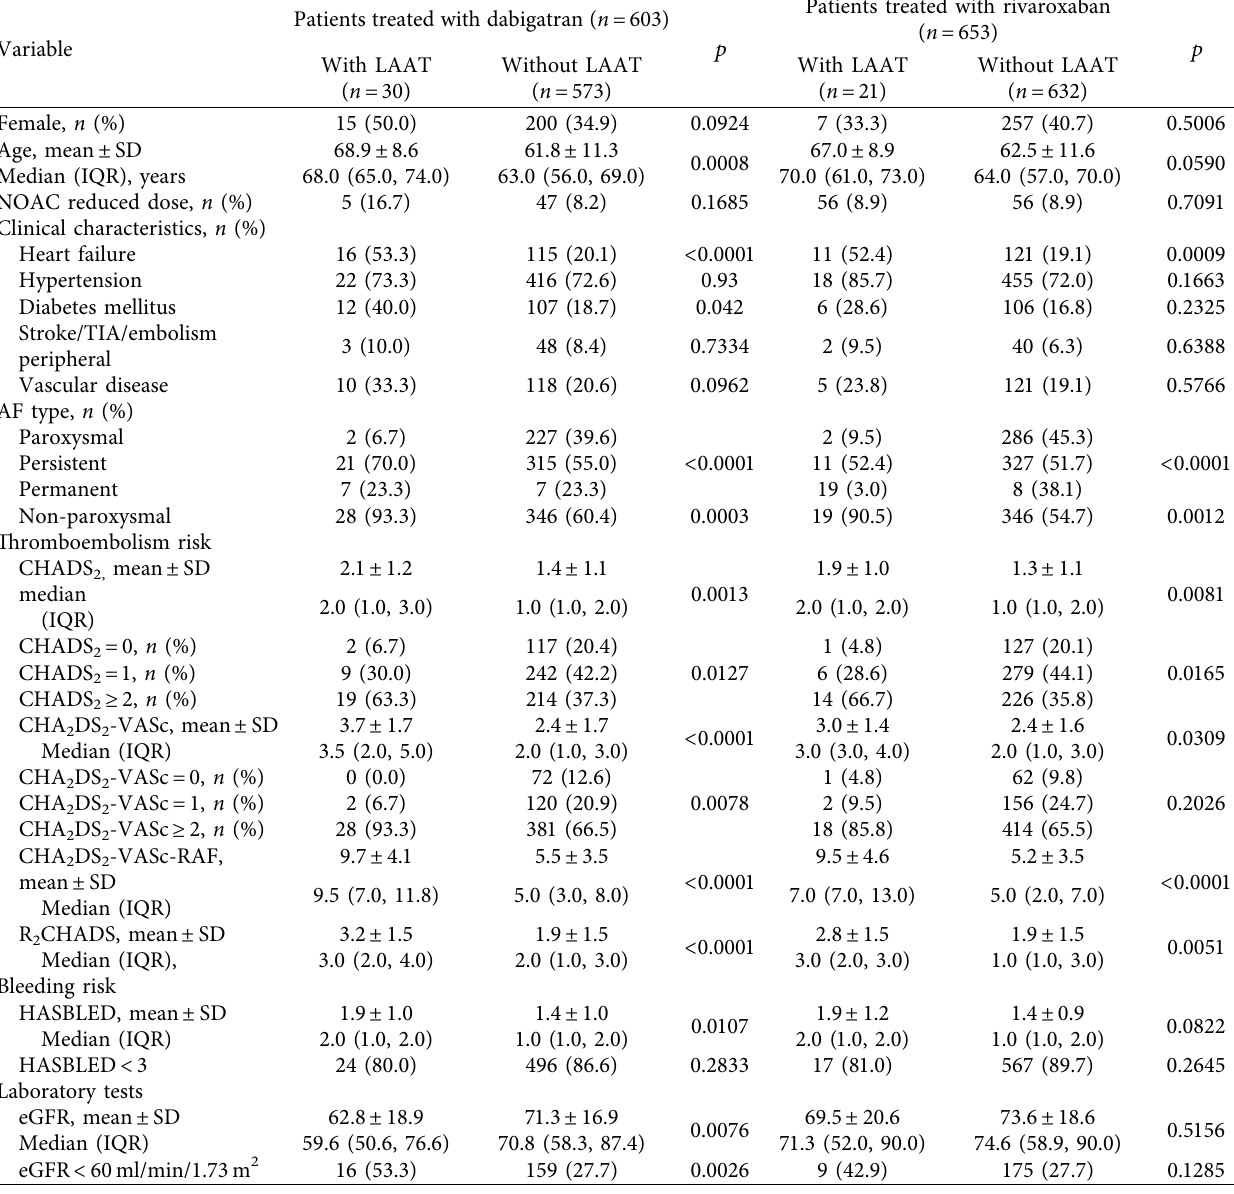
Table 3: Comparison of patients with and without left atrial appendage thrombus among patients treated with dabigatran and rivaroxaban. Variable